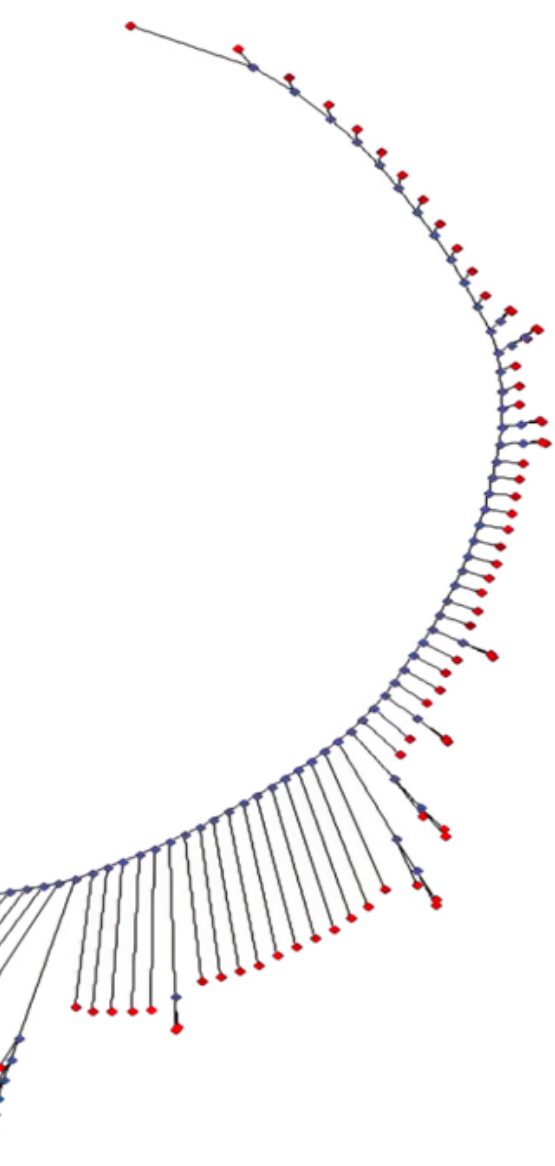
Figure 3. Clustering results of the graduation destinations of the graduates from higher education institutions.